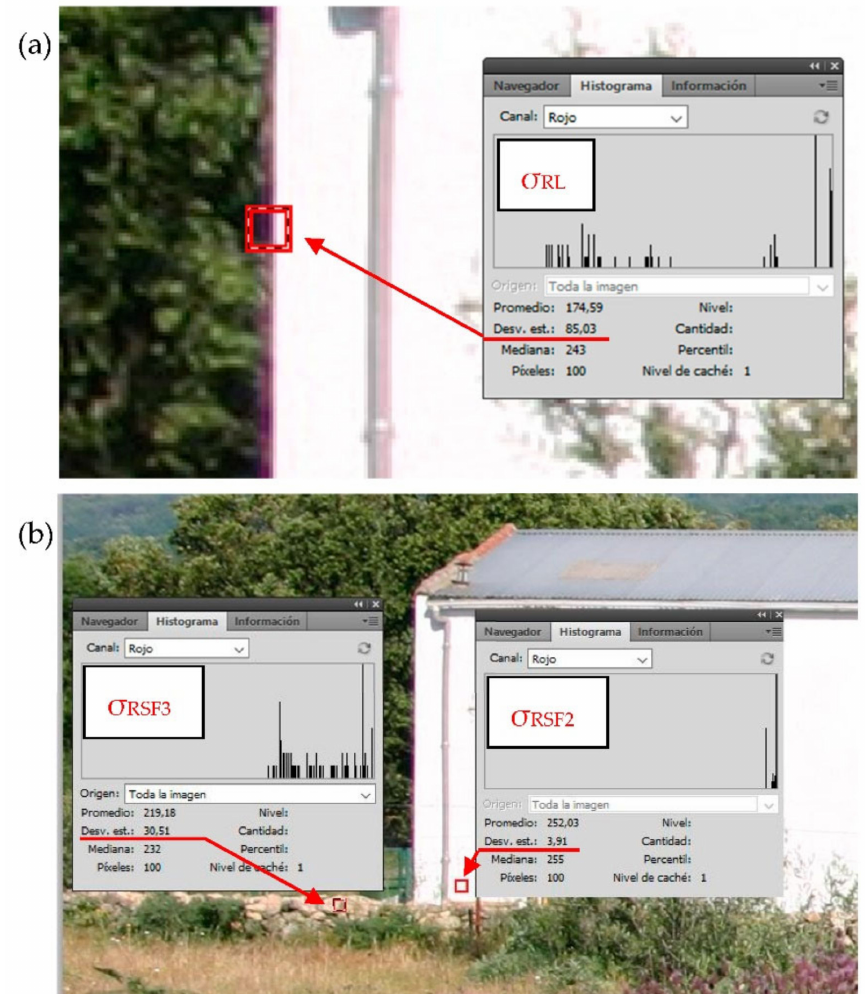
Figure 1. Colour histogram statistics. 1.( a ) Example of a measurement window for the sharp- ness of building lines. The standard deviations ( σ x ) of the three colour channels (x = R, G, B) in a measurement area that includes the line (L) under study: R ( σ RL ), G ( σ GL ), and B ( σ BL ). The line is determined to be sharp if any σ xL is greater than 40 (example of red channel SD measurement: σ RL = 85.03). 1.( b ) Example of measurement windows for internal contrast assessment of the building. For its calculation, σ x comparisons of the three colour channels (x = R, G, B) are used between two independent measurement areas, not necessarily adjacent: one in the building (roof (SF1) or façade (SF2) and another in the environment (most dominant exterior element (SF3)). As many as six comparison pairs can occur between the building and the environment: three comparisons of roof–environment and three comparisons of façade–environment: σ x SF1 vs. σ x SF3 and σ x SF2 vs. σ x SF3 , where x = R, G, B (example of red channel SD comparison between façade and